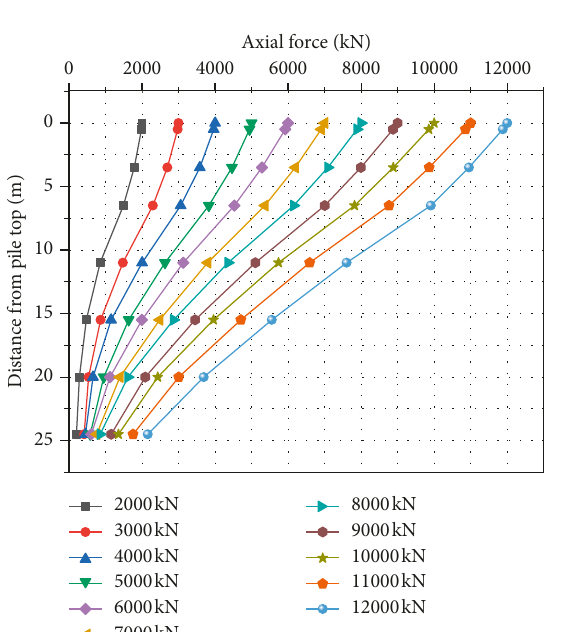
Figure 6: The Q-S curves of test piles.